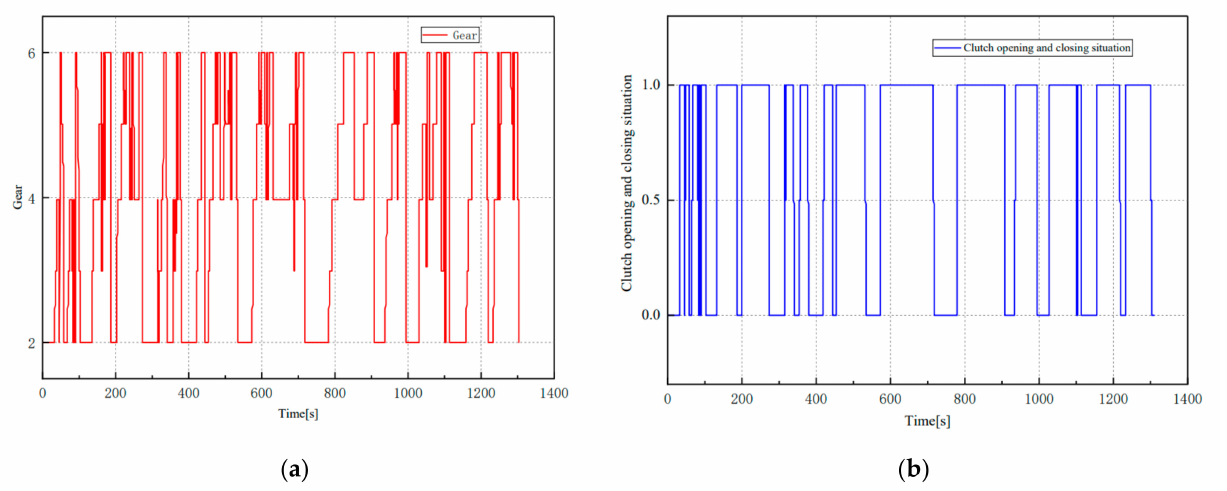
Figure 15. Relationship between the clutch’s position and the gear with time. ( a ) Gear. ( b ) Clutch’s